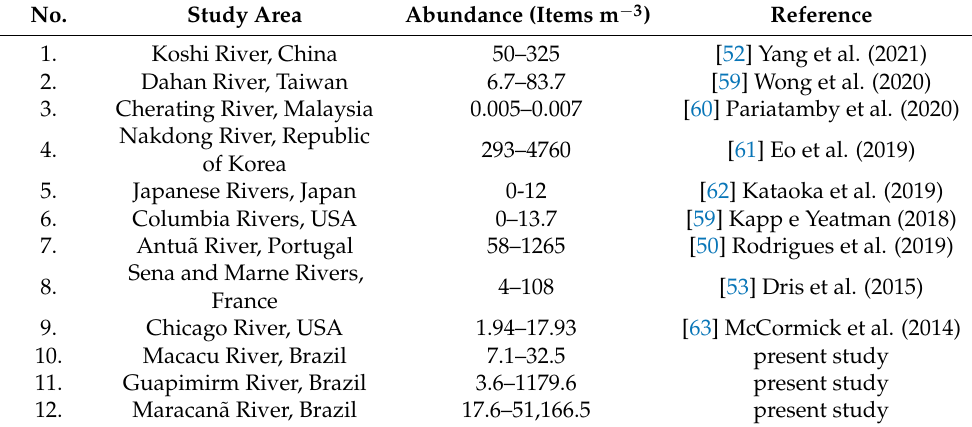
Table 3. Abundance of microplastic particles in the water column of rivers in several countries.